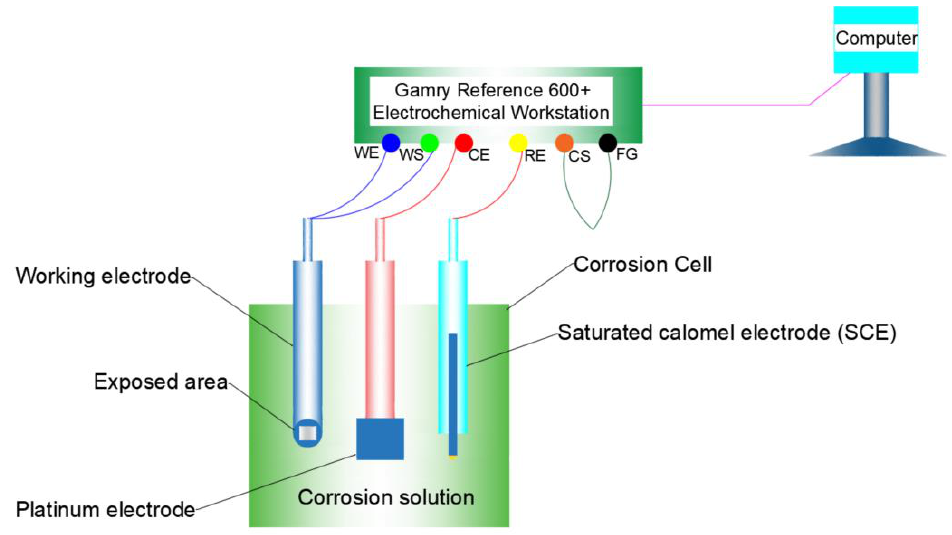
Figure 1. Schematic diagram of electrochemical test.